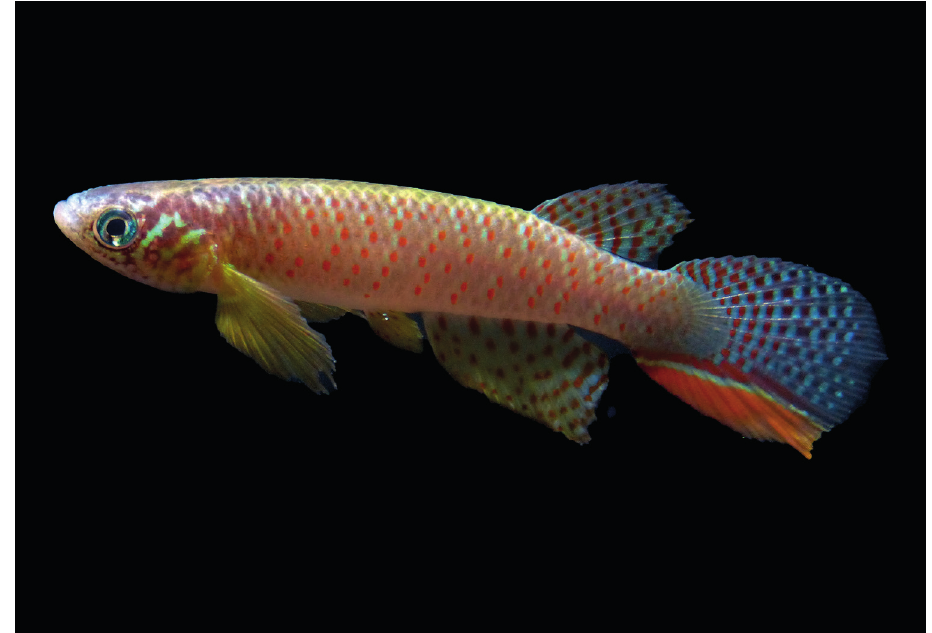
FIGURE 1 | Moema juanderibaensis , MNKP 16539, holotype, male, 41.9 mm SL (24 days after collection, left side), Bolivia, Santa Cruz, Santa Rosa del Sara.